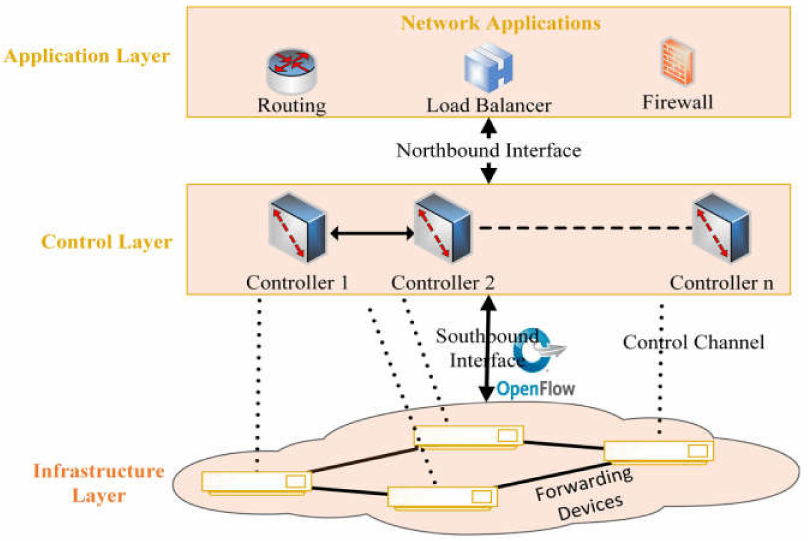
Figure 1. Standard SDN architecture